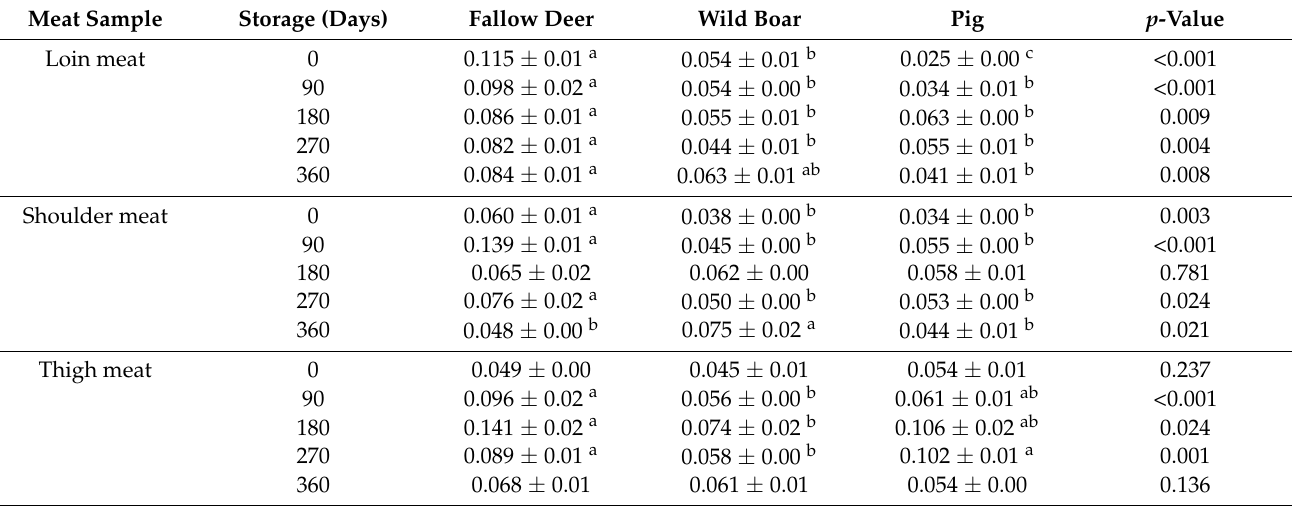
Table 6. The results of malondialdehyde determination in meat samples during storage at vacuum conditions (MDA mg/kg, mean ±